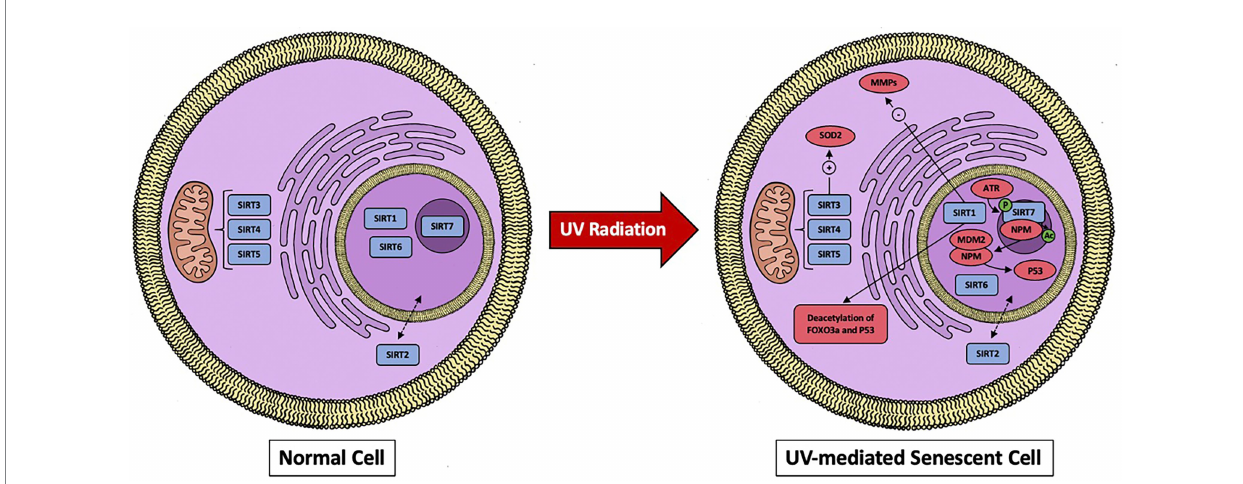
FIGURE 1 A visual representation of sirtuins localization in the cell and effects when dermal fibroblast undergoes UV-mediated damage. SIRT1 works through downregulating MMPs and by deacetylating FOXO3a and p53. SIRT7 activates p53 and the mitochondrial sirtuins (SIRT3, SIRT4, and SIRT5) will activate